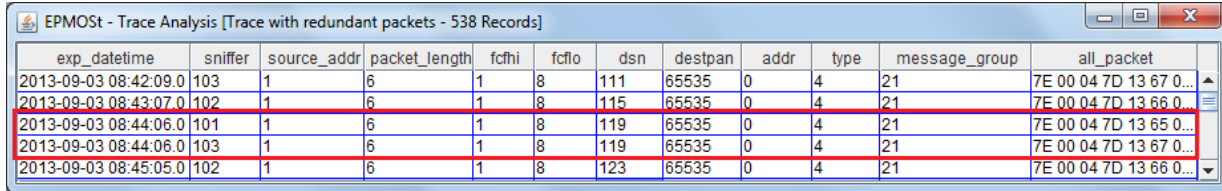
Figure 6. Example of trace with redundant packets.